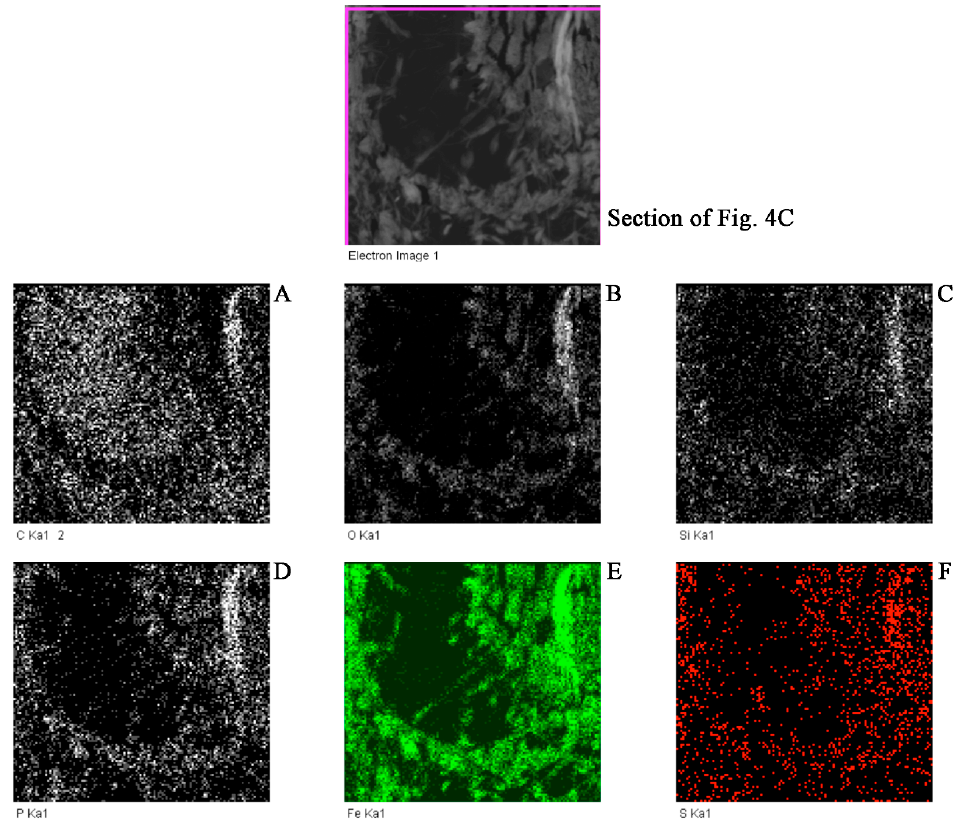
Figure 6. Mapping analysis of different elements of the sample showed in Figure 4C. ( A ) C; ( B ) O; ( C ) Si; ( D ) P; ( E ) Fe; ( F ) S.